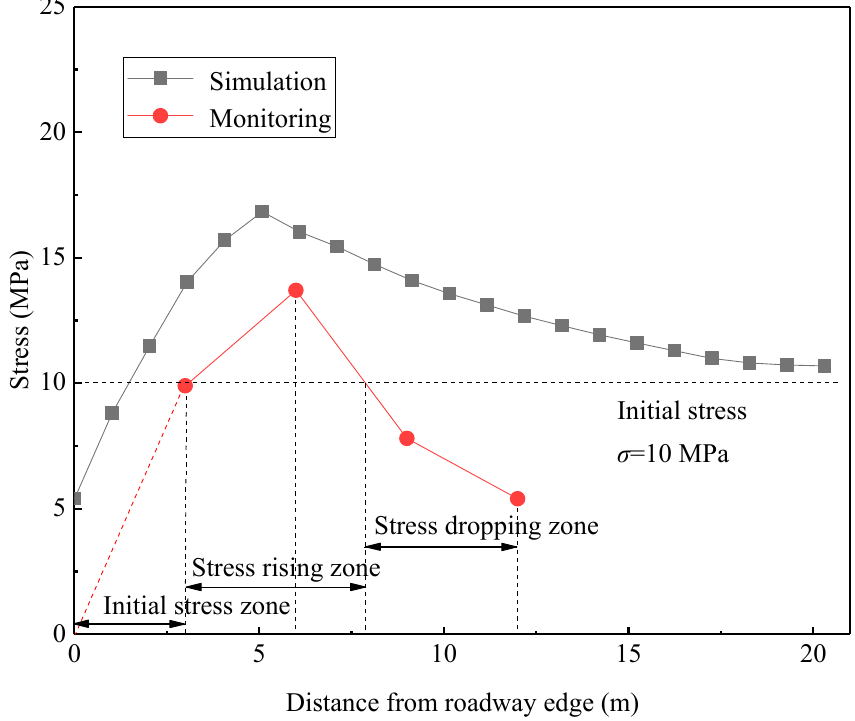
Figure 20. Distribution law of lateral abutment pressure in working face.